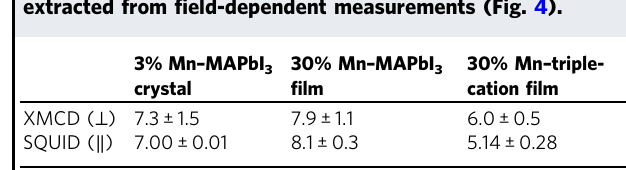
Table 2 Overview of magnetic moment values in μ B extracted from fi eld-dependent measurements (Fig. 4).